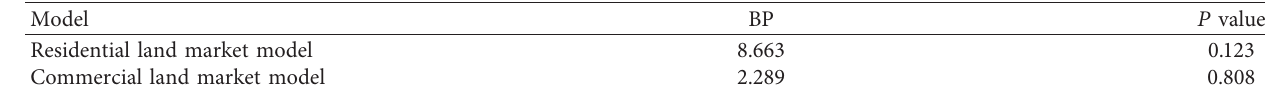
Table 7: The results of the heteroscedasticity test.